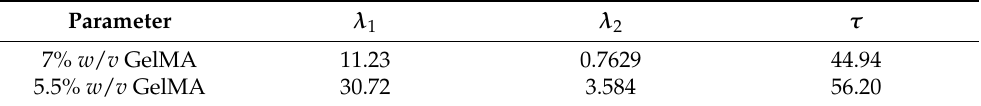
Table 2. Fitted results of GelMA microfiber with different concentrations.